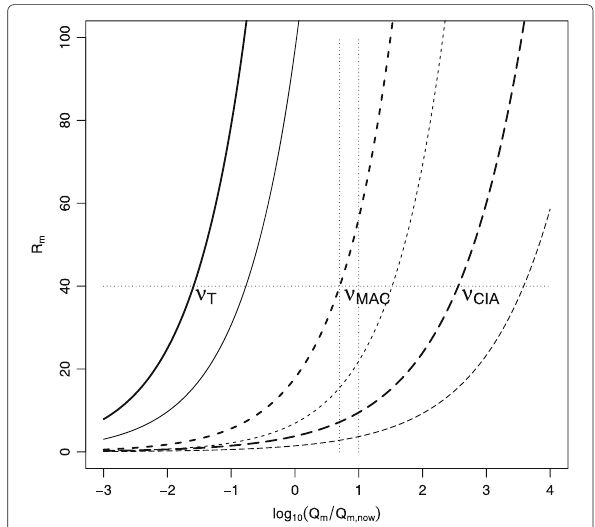
Fig. 1 Feasibility of running a dynamo in a liquid silicate mantle in Mars as a function of mid-mantle heat flux Q m . The heat flux is scaled relative to the present-day heat flux Q m , now as estimated by Sohl and Spohn (1997). ν T , ν MAC , and ν CIA show three families of potential dynamos driven by different types of flows (see text). Thickandthin lines of each pair denote low and high estimates of silicate electrical conductivity, σ (8.9–22.9 S m − 1 ). R m valuesgreaterthan40( horizontal dottedline ) indicate feasible range for dipolar dynamos. Turbulent flow speeds are capable of running dynamos at any mantle heat flow provided that the mantle is liquid. Magnetostropic dynamos are also feasible in the high heat flux epoch early in Mars evolution ( vertical dottedlines ; 0–1 Gyr according to Breuer et al. (2010)). Geostrophic dynamos do not seem feasible under any realistic heat flow